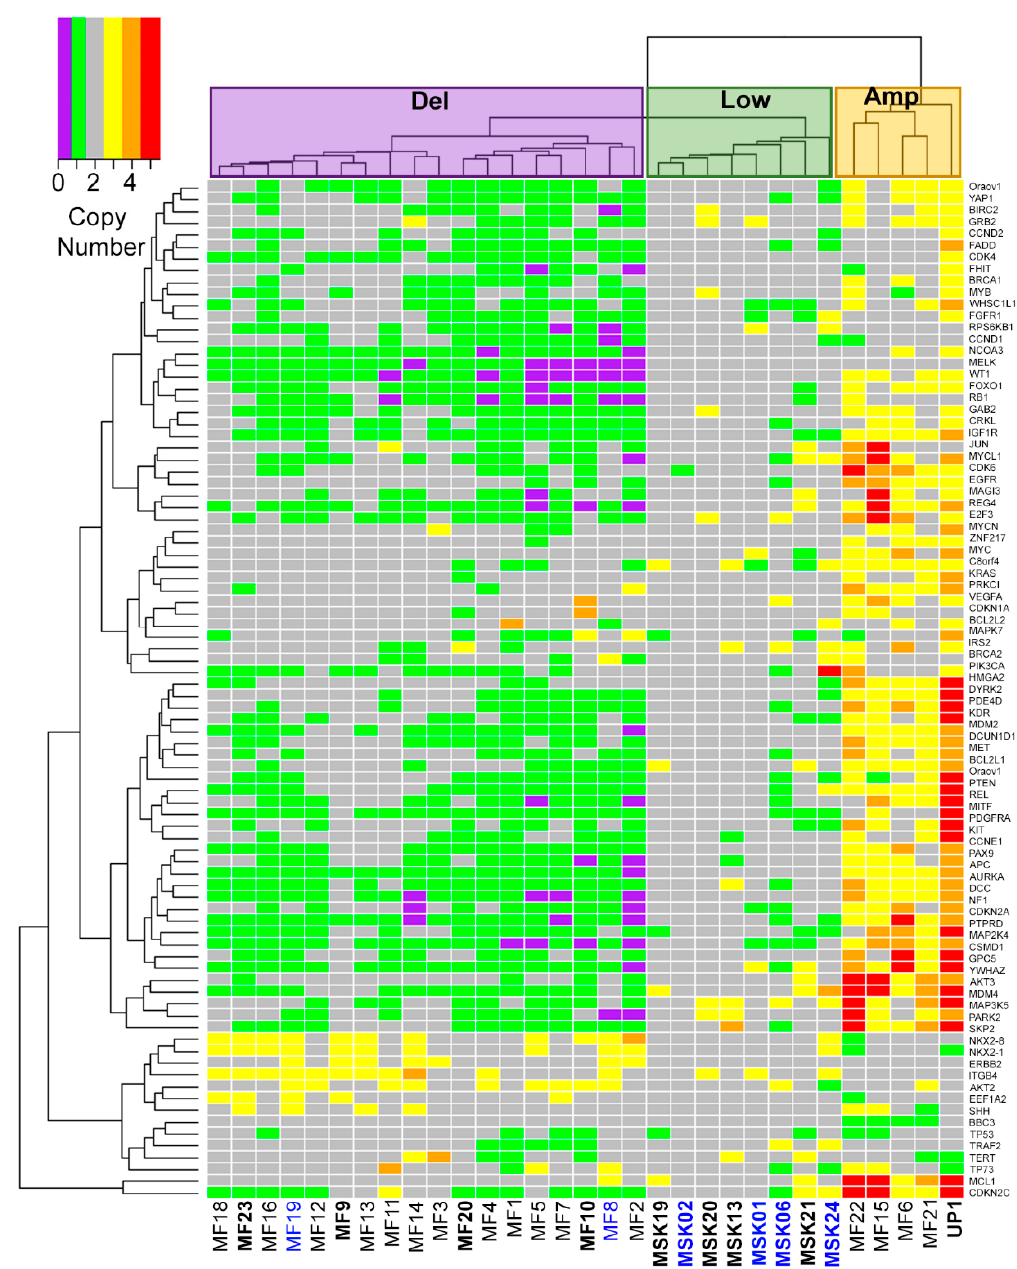
Figure 1. Three genomic structural variant signatures detected in MCC tumors by NanoString nCounter. Tumor DNA from 31 patients with MCC from Memorial Sloan Kettering (MSK), Marshfield Clinic (MF), and the University of Pennsylvania (UP) were subjected to Nanostring nCounter CNV analysis. CNV alterations for 86 gene loci commonly altered in cancer were ascertained and plotted as a heatmap. Three cluster groups denoted as Del (deletion) for group 1, Low for group 2, and Amp (amplification) for group 3. Bold indicates virus positive MCC (VP-MCC) tumors. Blue indicates metastatic tumor. Table 1. Patient Summary.